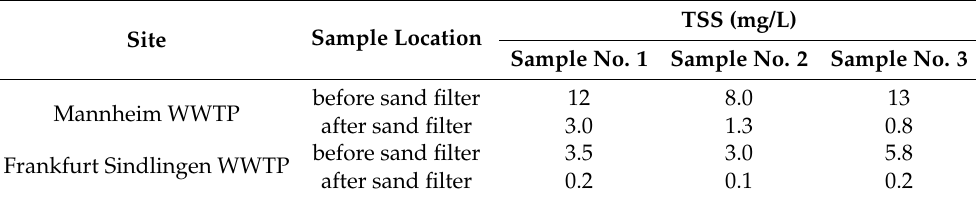
Table A1. TSS concentration of sand filter influent and effluent samples during each sampling event at the Mannheim and Frankfurt Sindlingen